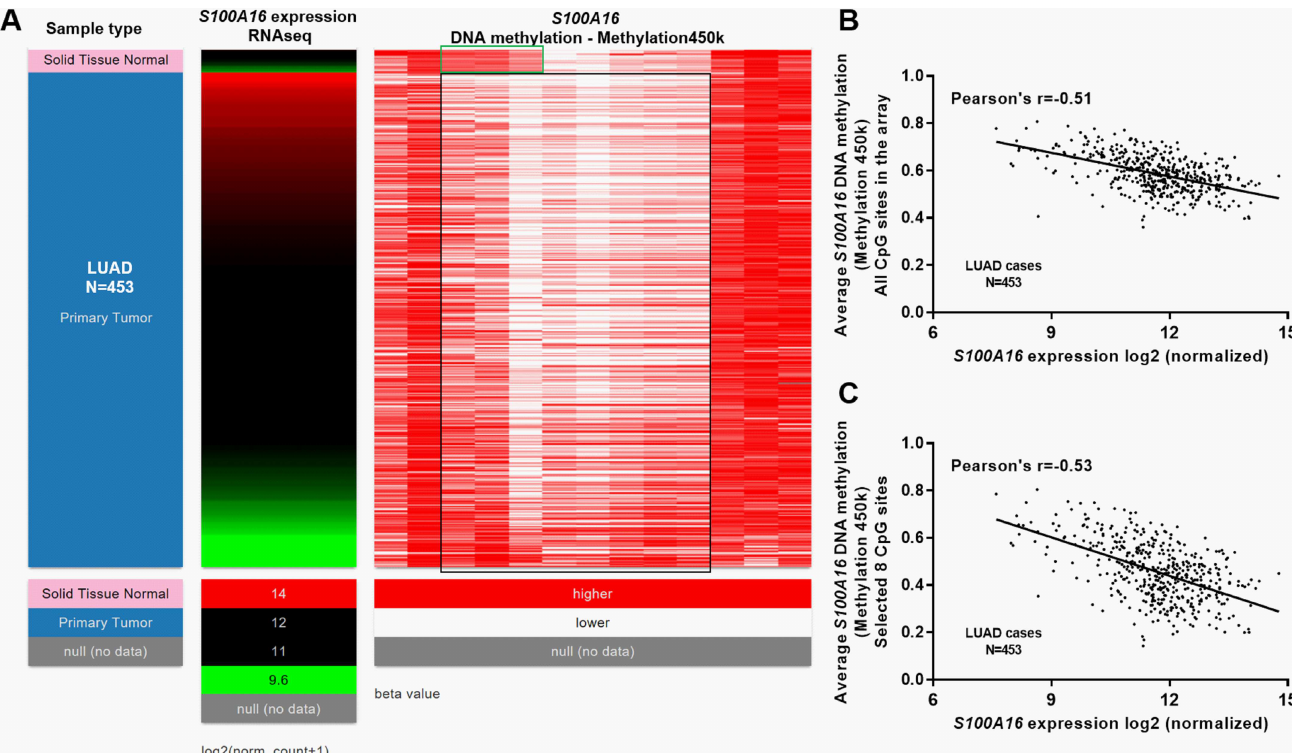
Fig 4. The correlation between S100A16 expression and its DNA methylation in LUAD tissues . A. Heatmap of the correlation between S100A16 expression and its DNA methylation. B-C. Regression analysis of the correlation between S100A16 expression and the average methylation of all CpG sites in the array (B) or the selected 8 CpG sites (C).